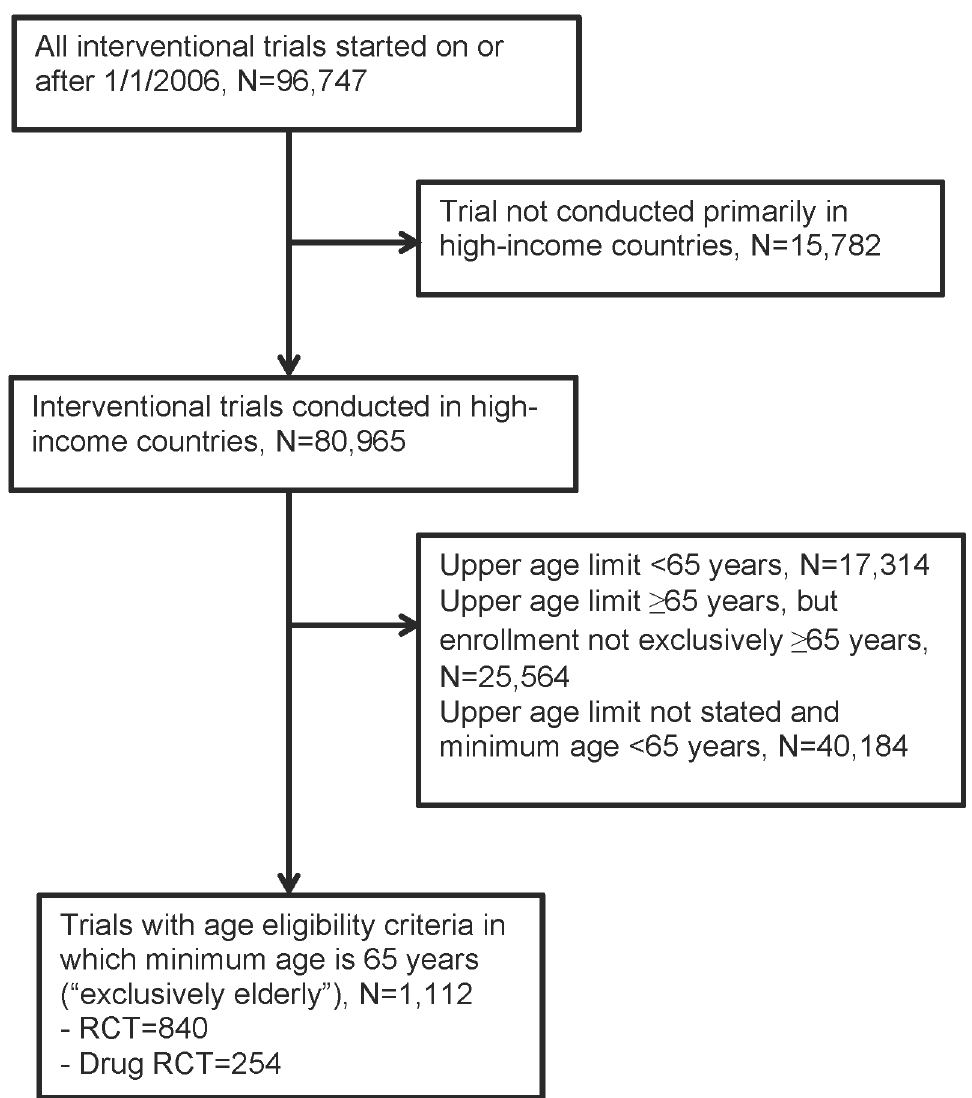
Fig 1. Flowchart for inclusion of clinical trials registered in ClinicalTrials.gov and focusing on elderly